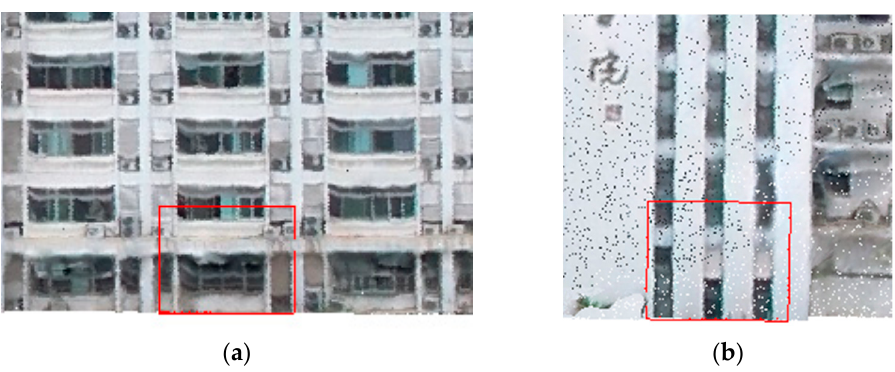
Figure 12. The experimental area of artificial holes (red rectangles represent the location of artificial holes). ( a ) Artificial hole 1, ( b ) Artificial hole 2.